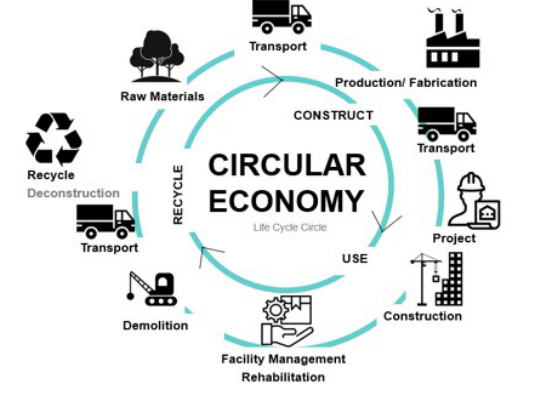
Figure 1. Circular Economy Principles.